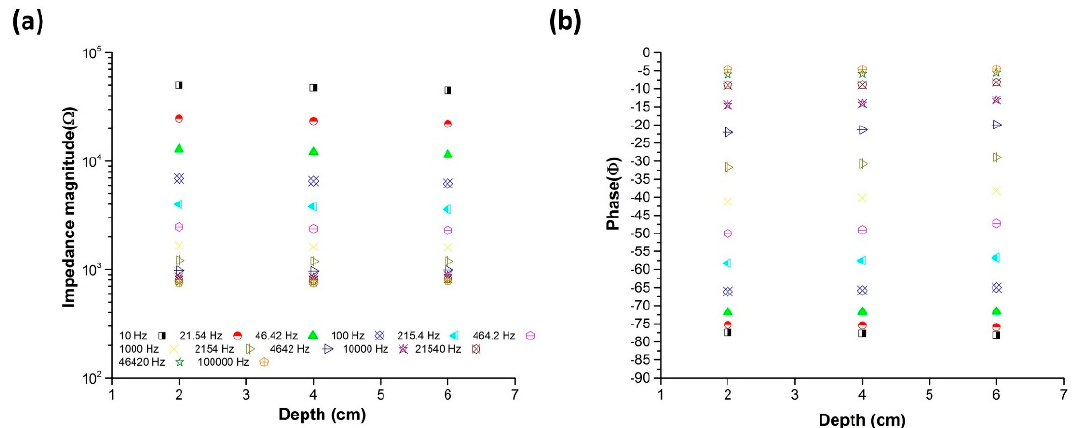
Figure 5. Impedance spectra of the monopolar injection needle measured at different depths in saline: ( a ) magnitude and ( b ) phase.